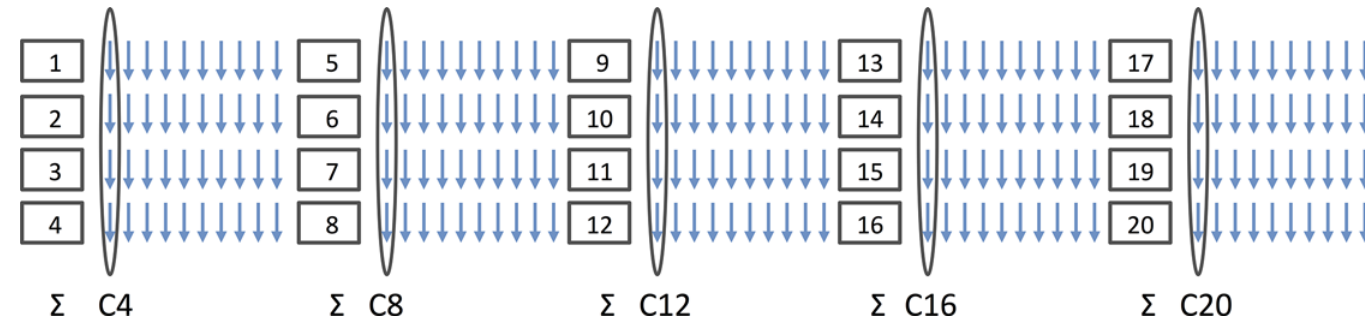
Fig 1. Summation of the first spectra for four subsequent trains in order to improve spectral resolution and to assess PCr depletion over time (i.e. five time-points, i.e., contraction C4; C8; C12; C16; C20). Each rectangle represents one contraction of 20 seconds, each arrow one MR spectrum acquired from 2 sec after each